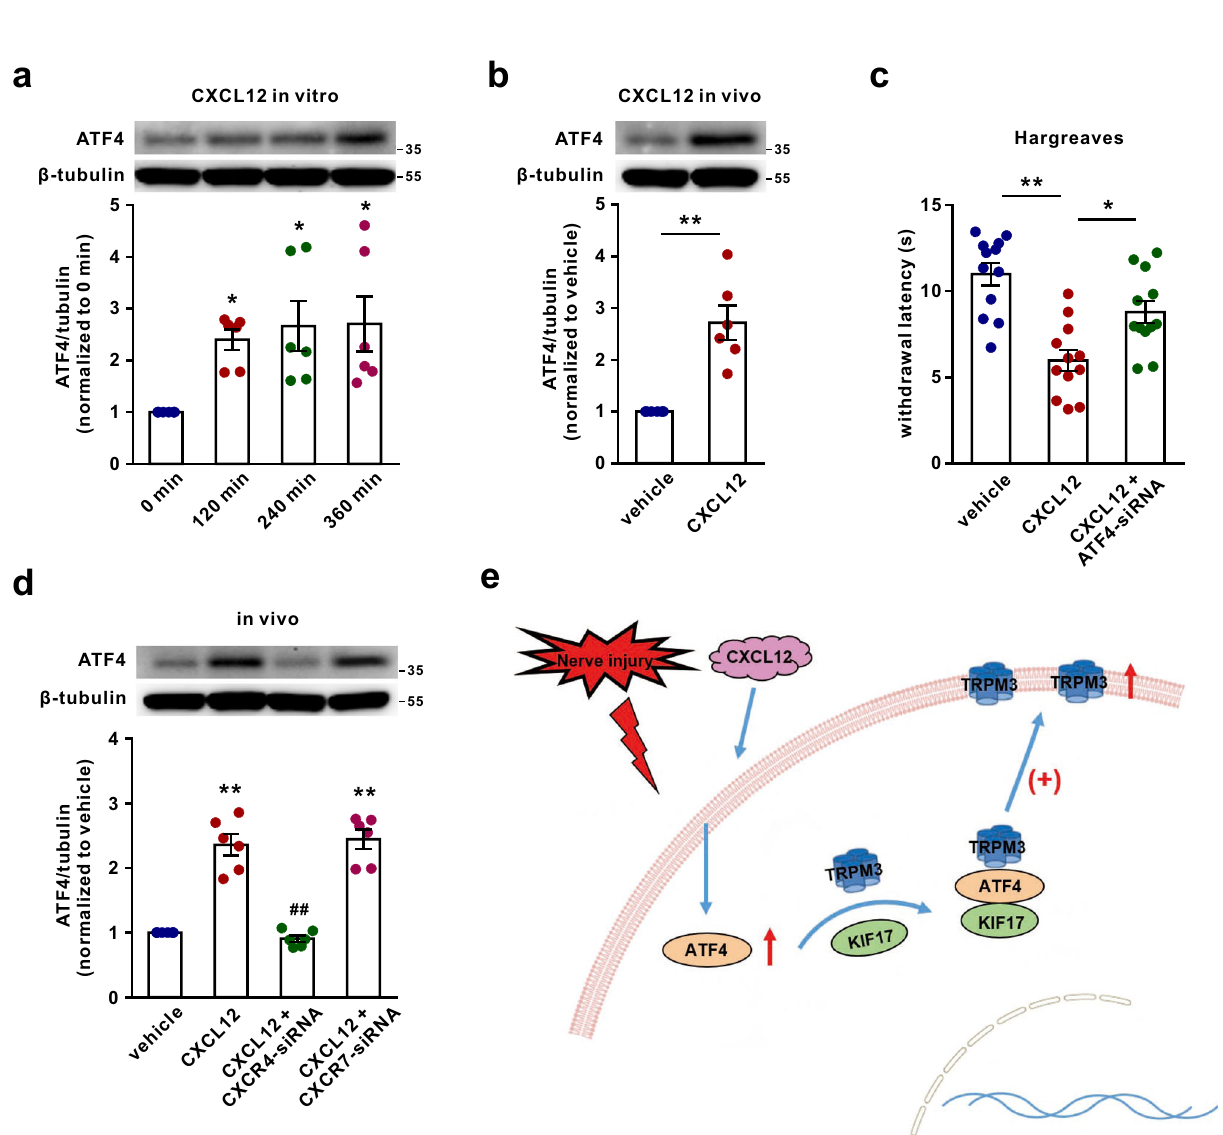
Fig. 8 KIF17 is involved in ATF4-dependent TRPM3 membrane traf fi cking. a Colocalization of the KIF17, ATF4 and TRPM3 proteins in mouse DRG sections. Scale bar, 200 μ m. b Colocalization of KIF17 mRNA , ATF4 mRNA and TRPM3 mRNA in mouse DRG sections. Scale bar, 20 μ m. c Colocalization of the KIF17, ATF4 and TRPM3 proteins in DRG neurons was detected by SIM. Scale bar, 5 μ m. d , e Changes in the membrane expression of TRPM3 in the DRG after KIF17 knockdown ( d ) or KIF17 overexpression ( e ). n = 6 mice per group. F (2,15) = 34.36, P = 0.0002 in d . F (2,15) = 20.48, P = 0.0005 in e . f The behaviours of KIF17 siRNA- and scrambled siRNA-injected mice were evaluated by the Hargreaves test. n = 6 mice per group. t 10 = 3.485, P = 0.0059. g The behaviours of KIF17-overexpressing and control mice were evaluated by the Hargreaves test. n = 6 mice per group. t 10 = 6.776, P < 0.0001. h ATF4 knockdown suppressed the increased expression of TRPM3 in the membrane induced by KIF17 overexpression. n = 6 mice per group. F (2,15) = 16.19, P = 0.0002 in naïve vs. KIF17-over, P = 0.0014 in KIF17-over vs. KIF17-over + ATF4-siRNA. i KIF17 knockdown inhibited the increase in TRPM3 expression on the cell surface induced by ATF4 overexpression. n = 6 mice per group. F (2,15) = 12.76, P = 0.0025 in naïve vs. ATF4-over, P = 0.0010 in ATF4-over vs. ATF4-over + KIF17-siRNA. ** P < 0.01. d , e , h , i One-way ANOVA followed by Tukey ’ s multiple comparisons test. f , g Two-tailed Independent Student ’ s t test. The error bars indicate the SEMs.